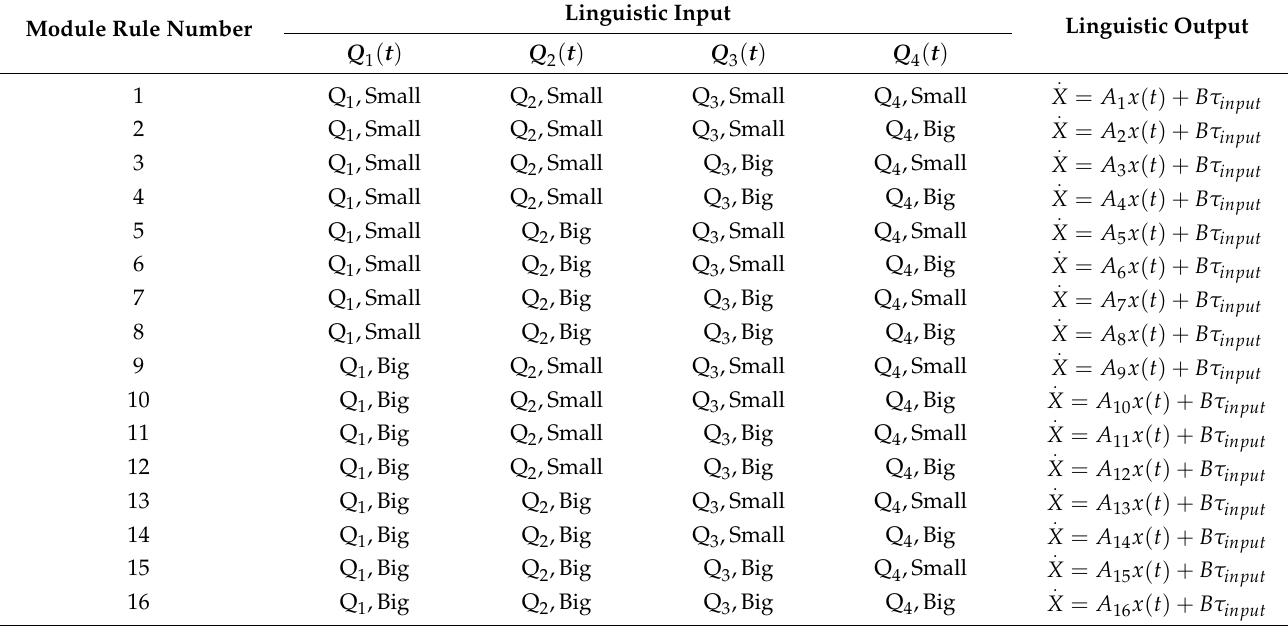
Table 2. Rules of the FJRM linearized